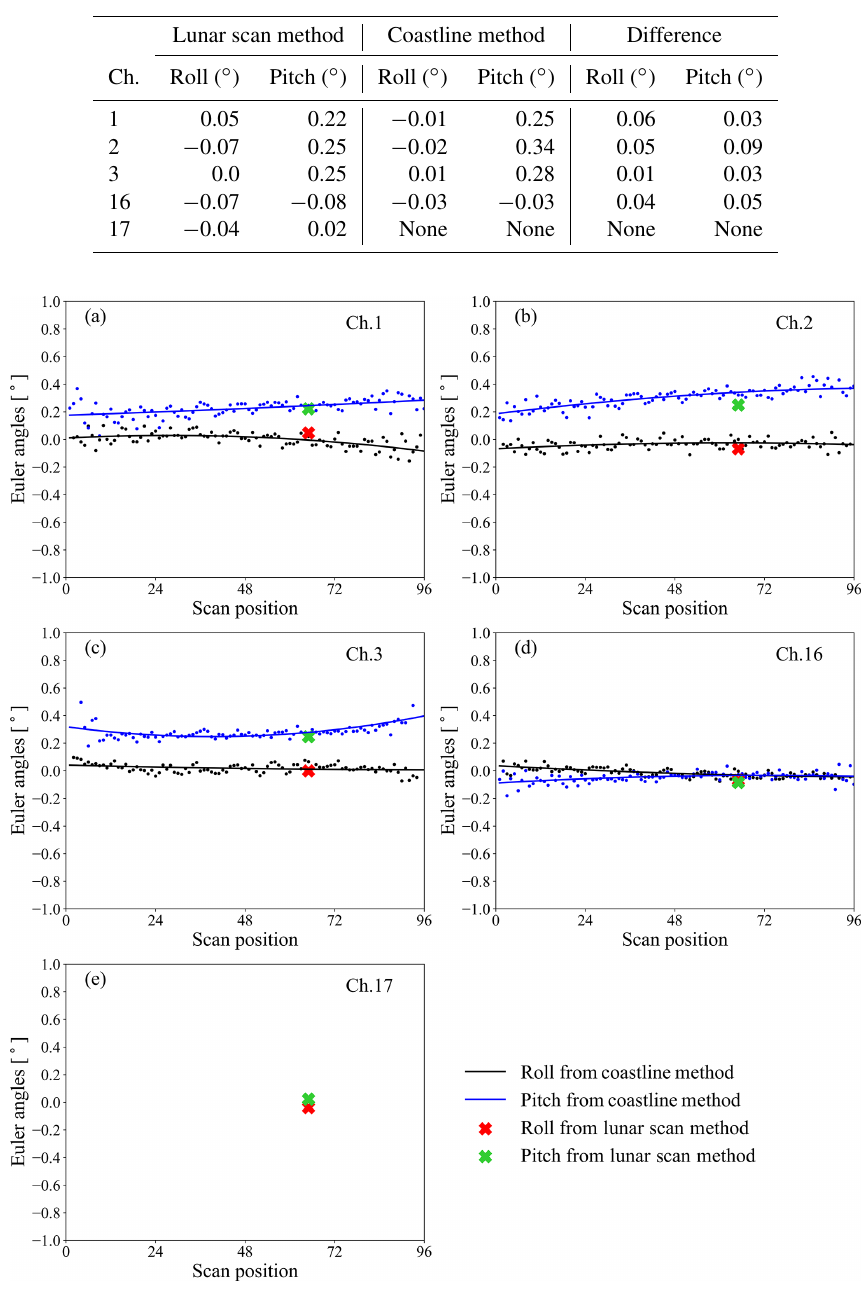
Table 1. Euler angles at FOV 66 retrieved from the lunar scan method and coastline inflection point method, as well as the absolute difference between them.